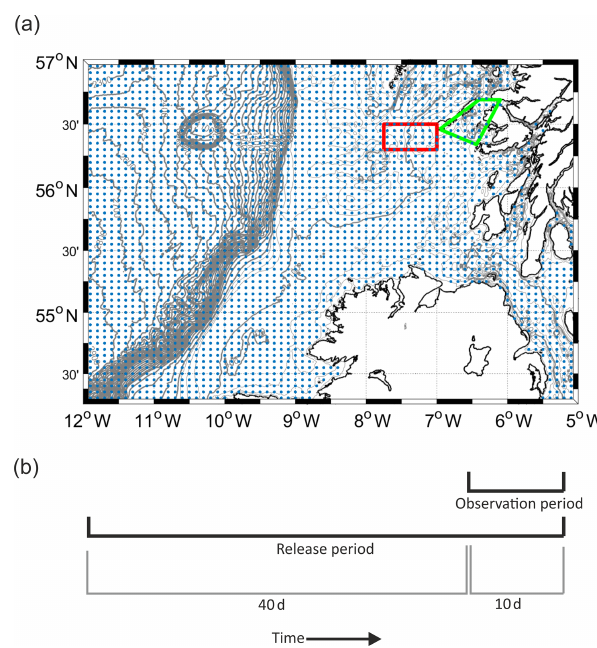
Figure 3. (a) Map of particle release locations, shown by blue points. The green polygon shows the observation region for 20m particles; the red polygon shows the observation region for 70m particles. (b) Schematic showing the observation period preceded by 40d of particle releases. Bathymetry contours from EMOD- net bathymetry (https://www.emodnet-bathymetry.eu/, last access: September